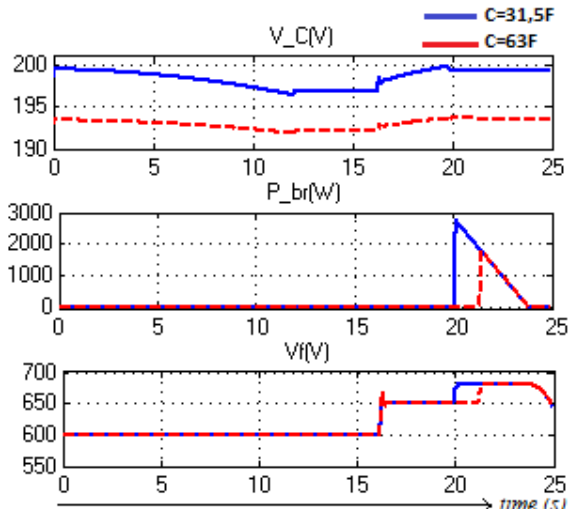
Fig. 16. Simulation diagrams for V SC = 199.5 V when C = 31.5 F and V SC = 193.41 V when C = 63 F.